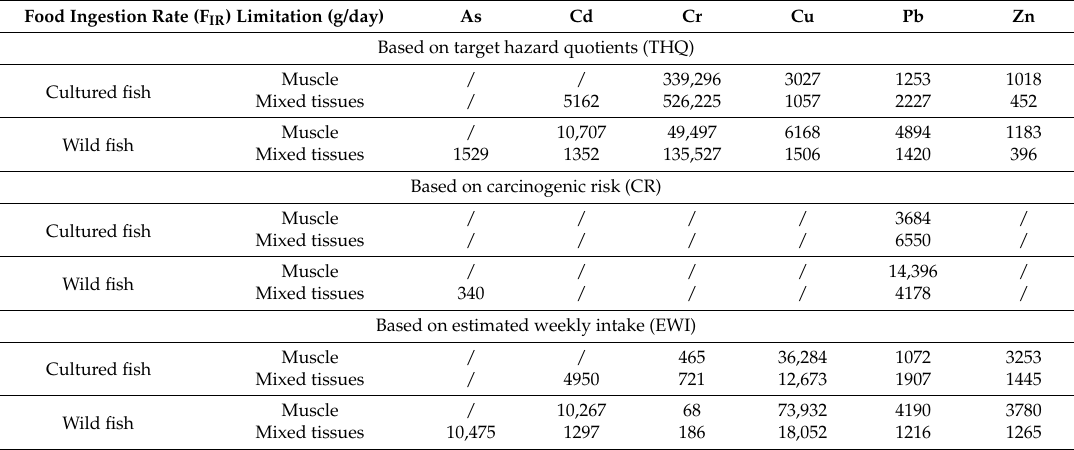
Table 5. Calculation results of food daily consumption (F IR ) limitation based on THQ, CR and EWI. Food Ingestion Rate (F IR ) Limitation (g/day)